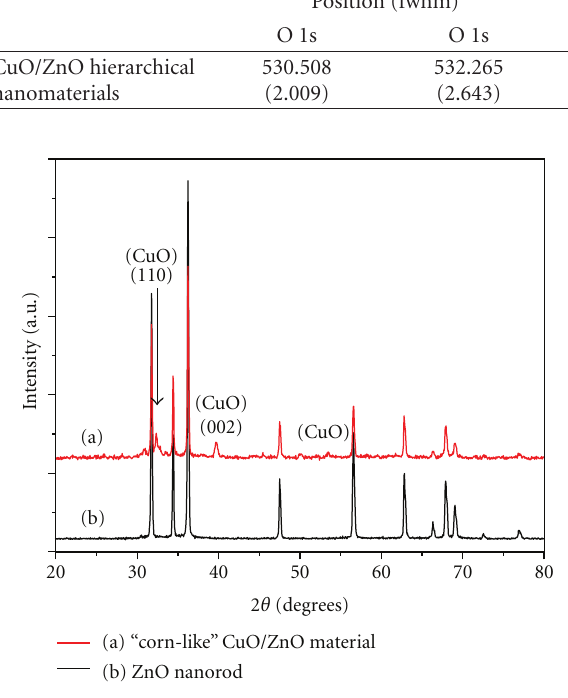
Figure 3: XRD patterns of the pure ZnO nanorods and the hier- archical CuO/ZnO